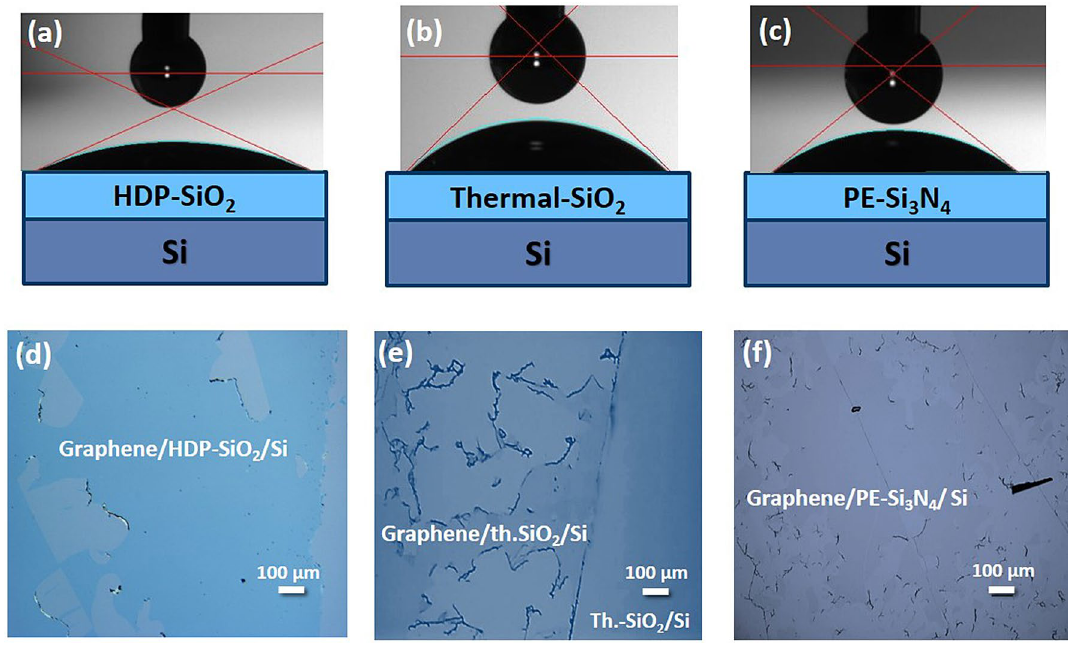
Figure 1. Representative pictures of wetting contact angles of ( a ) HDP-SiO 2 with WCA = 31°, ( b ) Thermal-SiO 2 with WCA = 45°, ( c ) PE-Si 3 N 4 with WCA = 38° film surfaces and optical microscopy pictures of graphene flakes transferred on corresponding surfaces ( d ) HDP-SiO 2 ( e ) Thermal-SiO 2 , ( f ) PE-Si 3 N 4 .